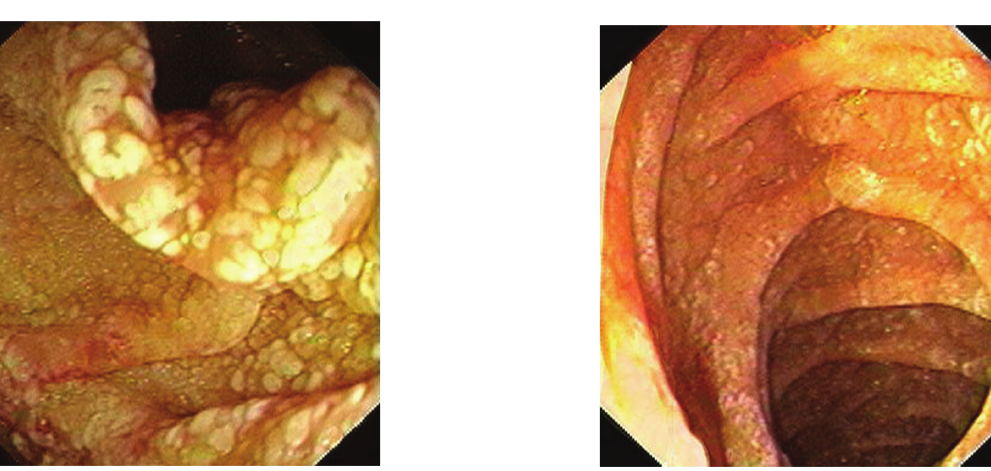
Figure 3: Whipple’s disease: endoscopic view of the proximal jejunum. Characteristic whitish areas protrude a little the above surrounding relief.